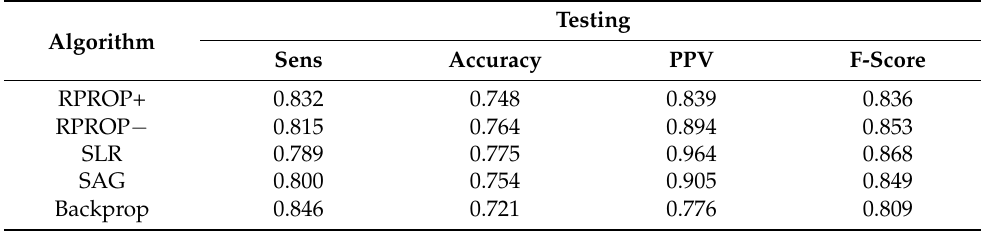
Table 9. Statistical evaluation parameters